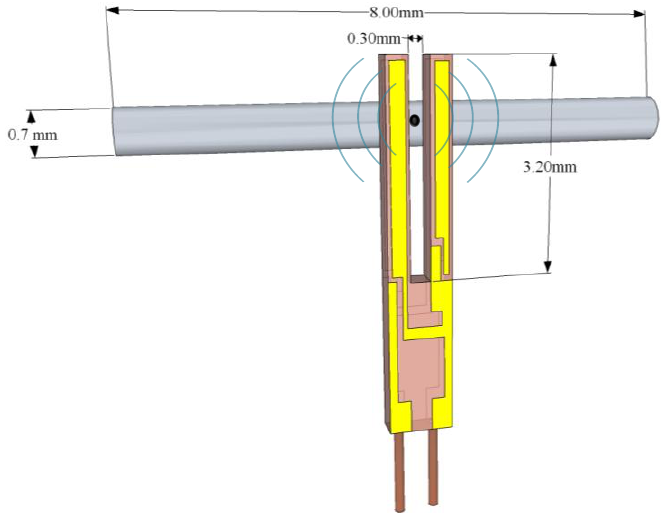
Figure 9. Sketch of an off-beam QEPAS spectrophone configuration. The micro-resonator tube is located close to the prongs of the QTF without touching them. The green circular lines indicate the acoustic